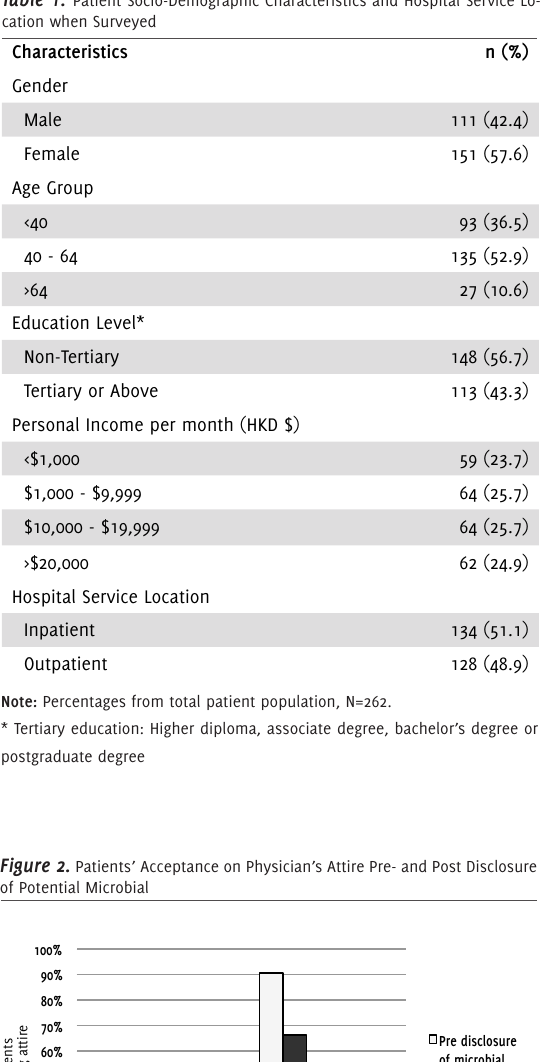
Note: Percentages from total patient population, N=262.